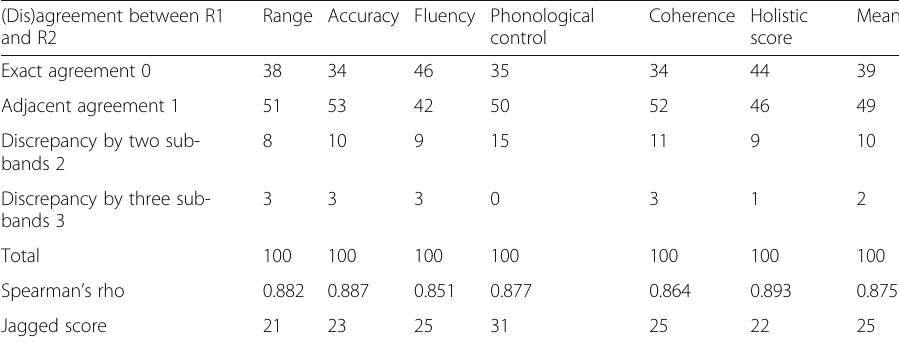
Table 4 Inter-rater agreement between Raters 1 and 2 in assessing speaking on the CEFR scales (Dis)agreement between R1 and